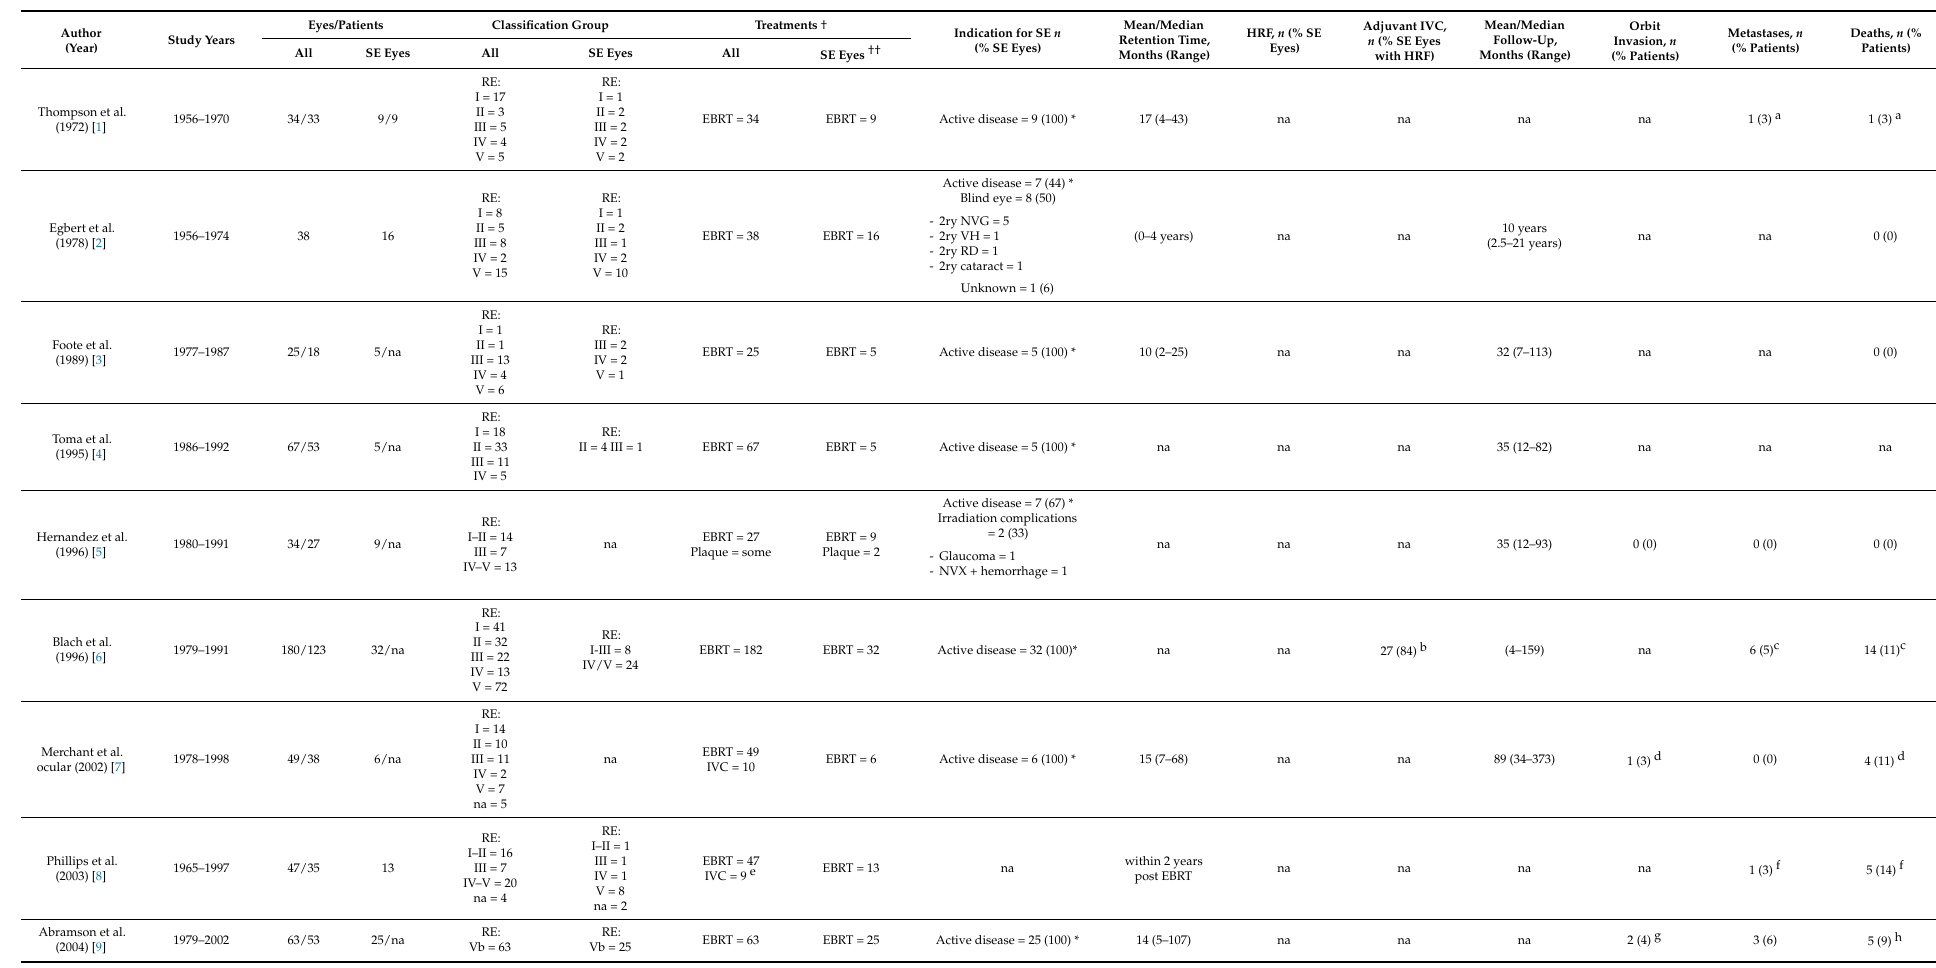
Table 1. Secondary enucleations (SE), orbital invasion, metastases and mortality rates after first-line external beam radiation therapy (EBRT): literature